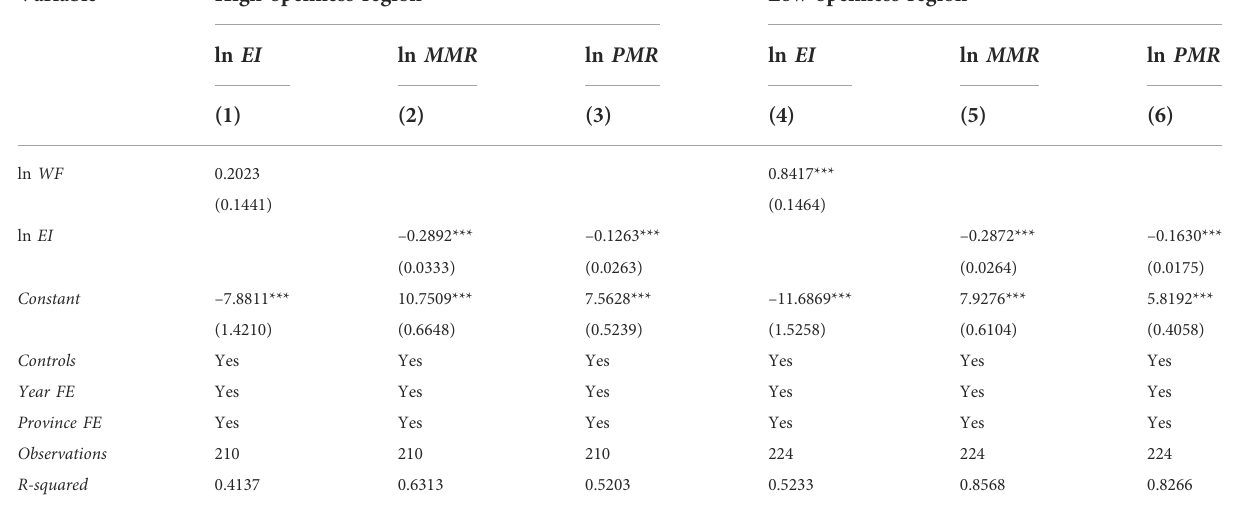
TABLE 7 Results for openness